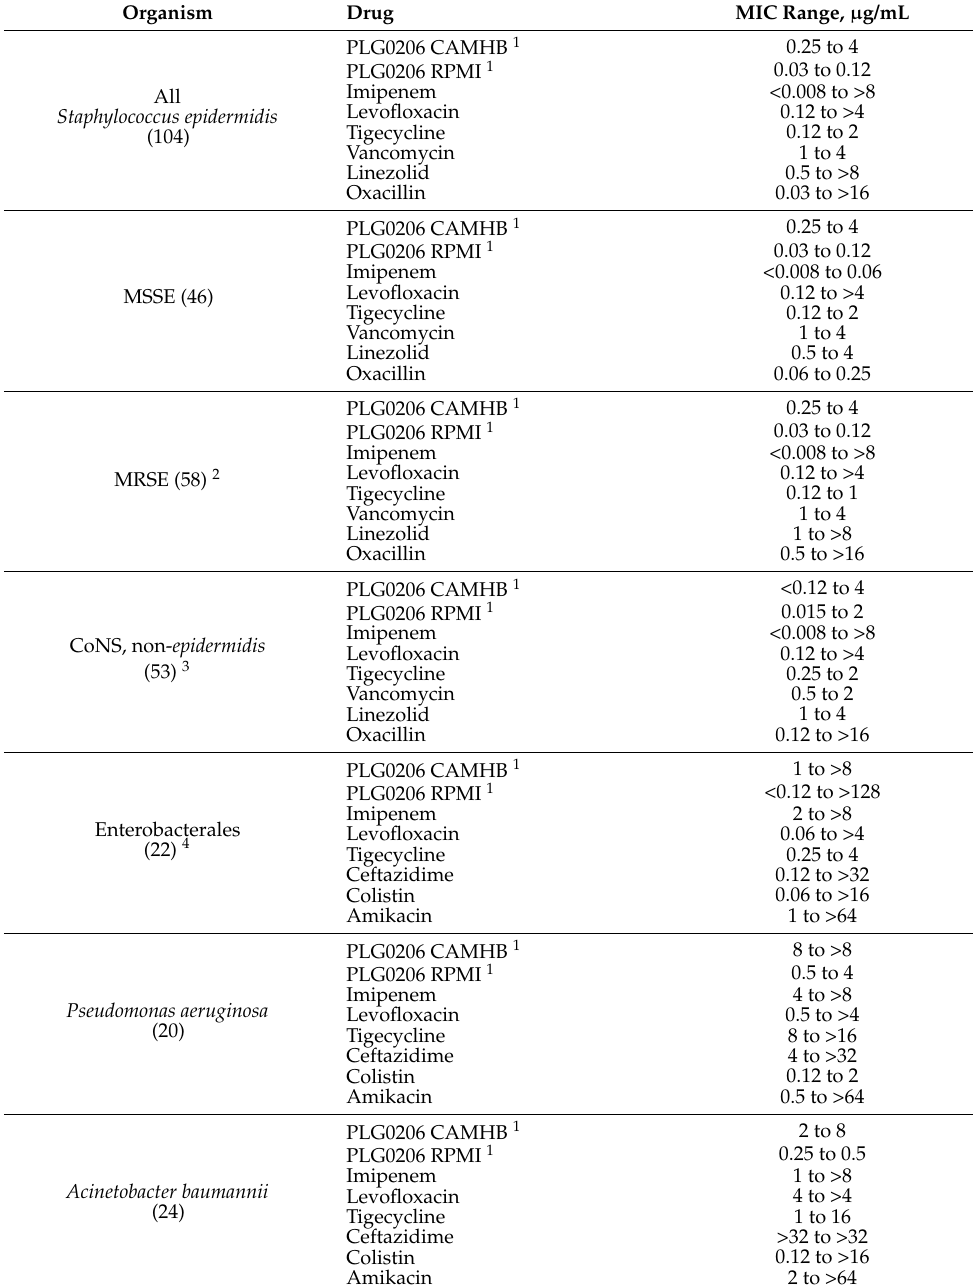
Table 1. Activity of PLG0206 and comparable products against coagulase-negative staphylococci and resistant Gram-negative pathogens. Data from Murray et al., 2020